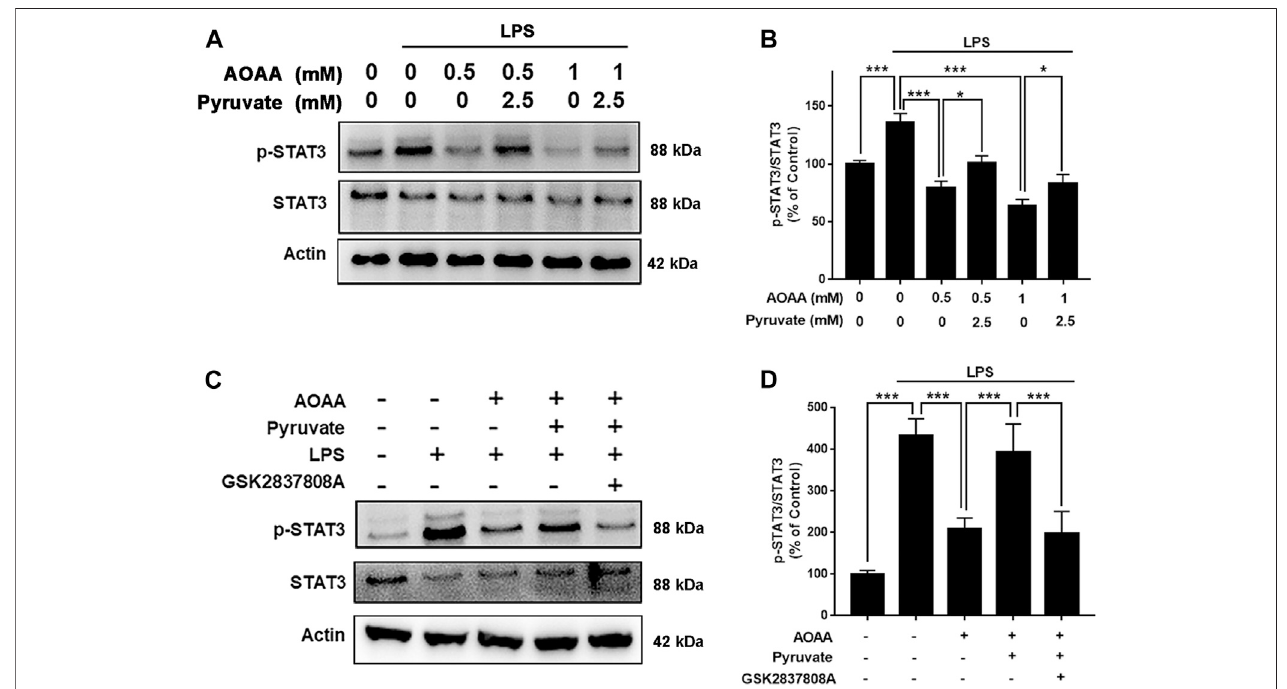
FIGURE 6 | MAS mediates LPS-induced microglial activation by regulating STAT3 phosphorylation. (A, B) Both 0.5 and 1 mM AOAA signi fi cantly decreased phosphorylation of STAT3 in the LPS-treated microglia, which was reversed by pyruvate treatment. (C, D) The LDH inhibitor GSK2837808A abolished the effect of pyruvate on STAT3 phosphorylation of the microglia treated with LPS and AOAA. After pre-treatment with 1 mM AOAA for 30 min, the BV2 cells were incubated with 2.5 mM pyruvate, 100 µM GSK2837808A, and 1 µg/ml LPS. 2 h after the incubation, Western blot assays were conducted. N (cid:2) 3. The data were collected from three independent experiments. *, p < 0.05; ***, p <